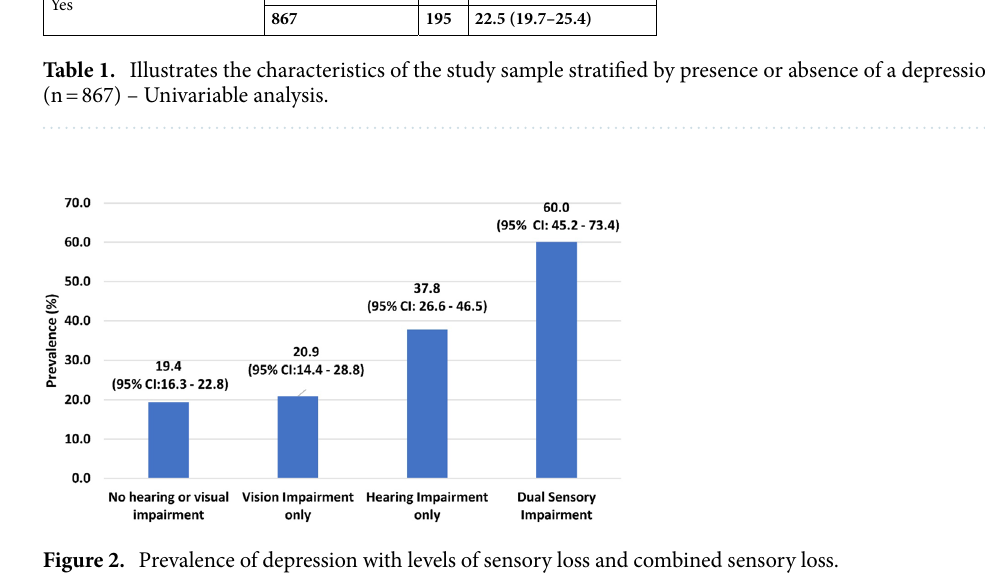
Figure 2. Prevalence of depression with levels of sensory loss and combined sensory